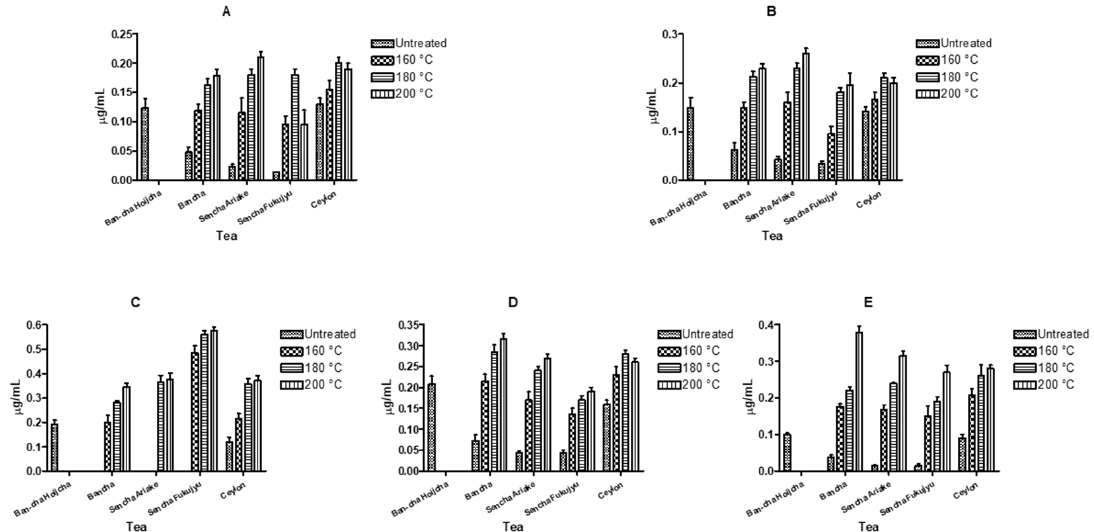
Figure 3. Effects of roasting temperature on the content of the selected pyrazines 2-ethyl-6-methyl-pyrazine ( A ), 2-ethyl-5-methyl-pyrazine ( B ), 2-ethyl-3,6-dimethyl-pirazine ( C ), 2-ethyl-3,5-dimethyl-pyrazine ( D ) and 2-acetyl-pyrazine ( E ). The roasting treatment and preparation for tea infusions were repeated three times. Each data value is expressed as mean ± standard deviation (n = 3).